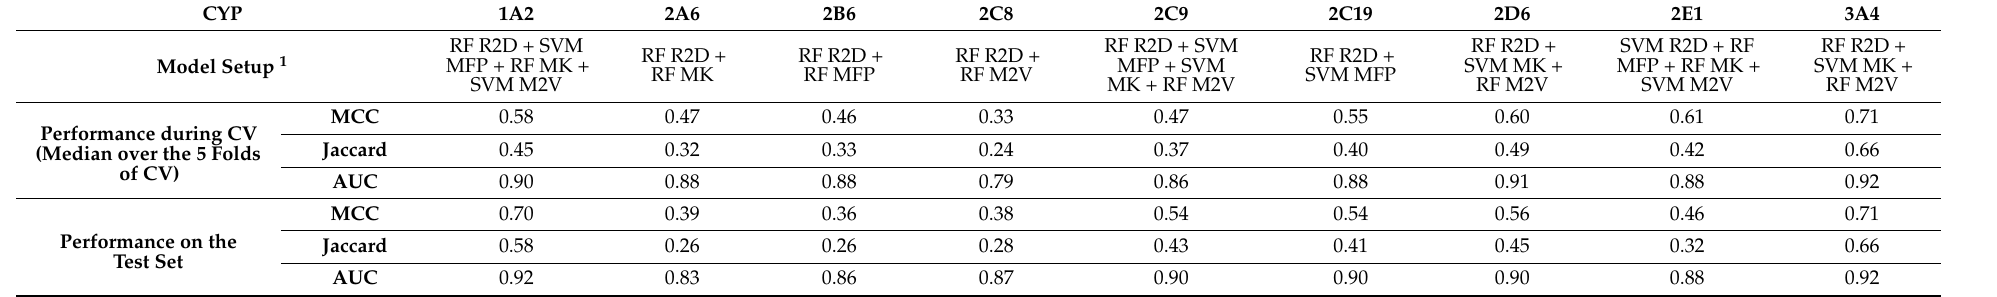
Table 6. Performance of the best-performing max voting classifiers by